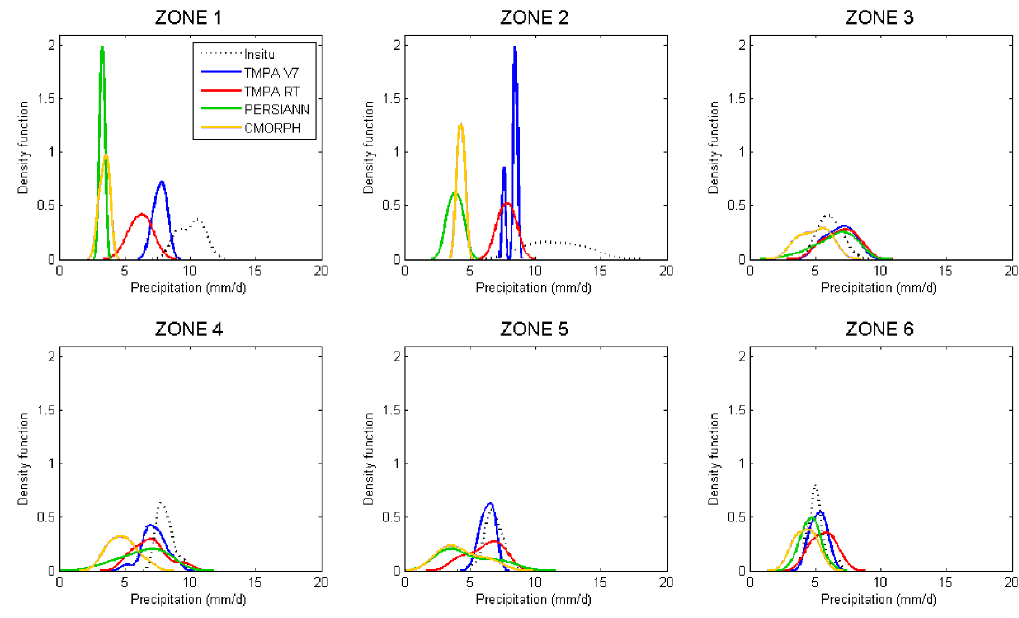
Figure 5. Comparison of the kernel probabilistic density of daily data between in situ and the satellite-based products in each zone .